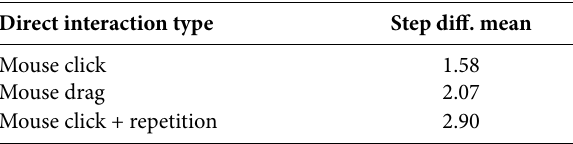
Table 6: Step difficulty means in direct interaction with the model, depending on the type of mouse interaction and repetition Direct interaction type